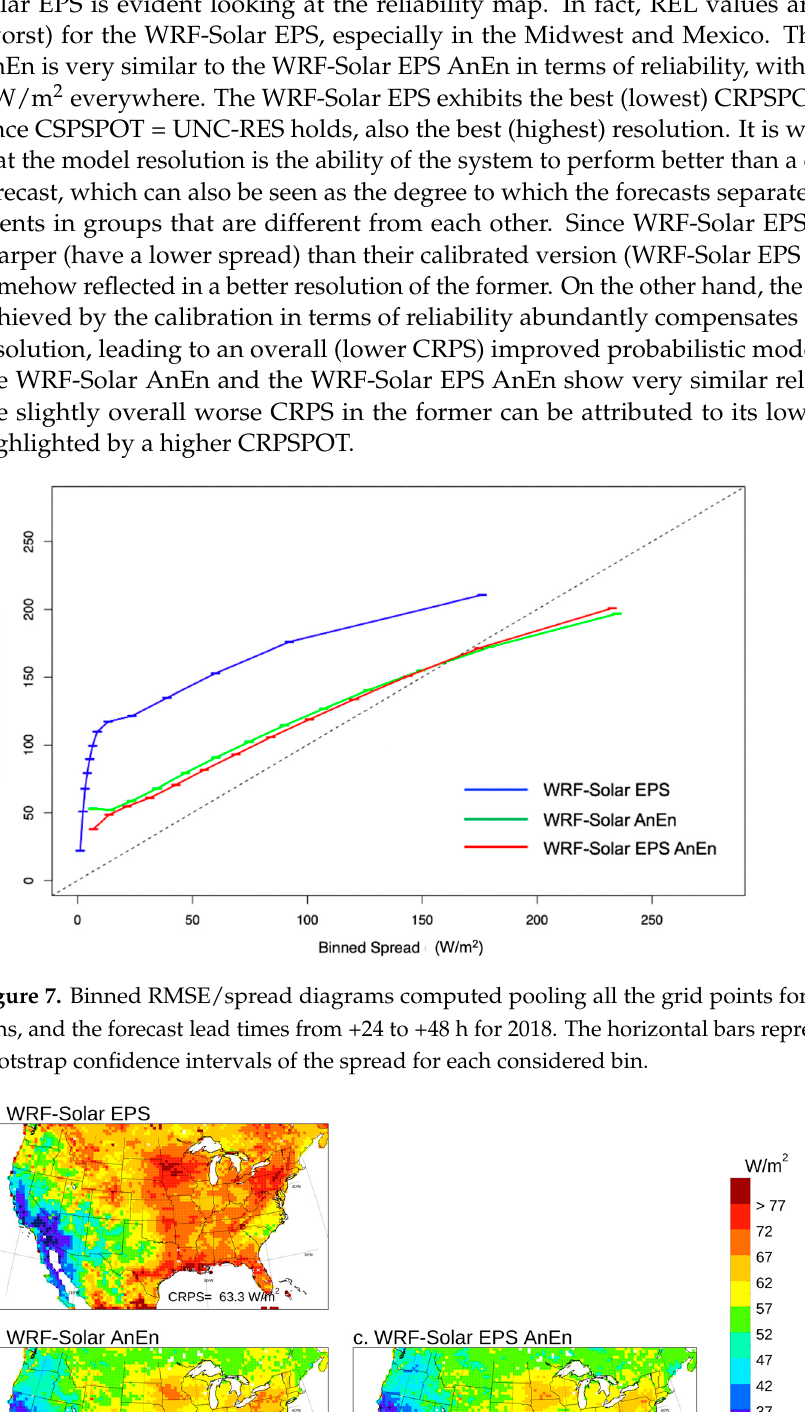
Figure 9. Potential continuous ranked probability score (CRPSPOT) map computed for GHI pooling runs and the forecast lead times from +24 to +48 h for 2018 together. Figure 10. Reliability (REL) map computed for GHI pooling runs and the forecast lead times from +24 to +48 h for 2018 together.